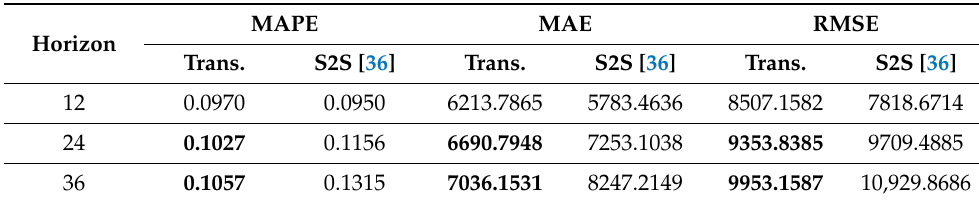
Table 2. Average performance metric per forecasting horizon. The bold numbers indicate where transformers outperform S2S.